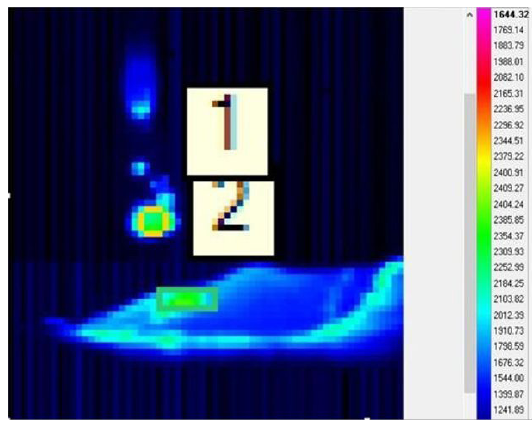
Figure 4. Highspeed infrared footage of [1] Detached droplets that fall into [2] weldpool without the luminous and thermal influence of the electric arc.